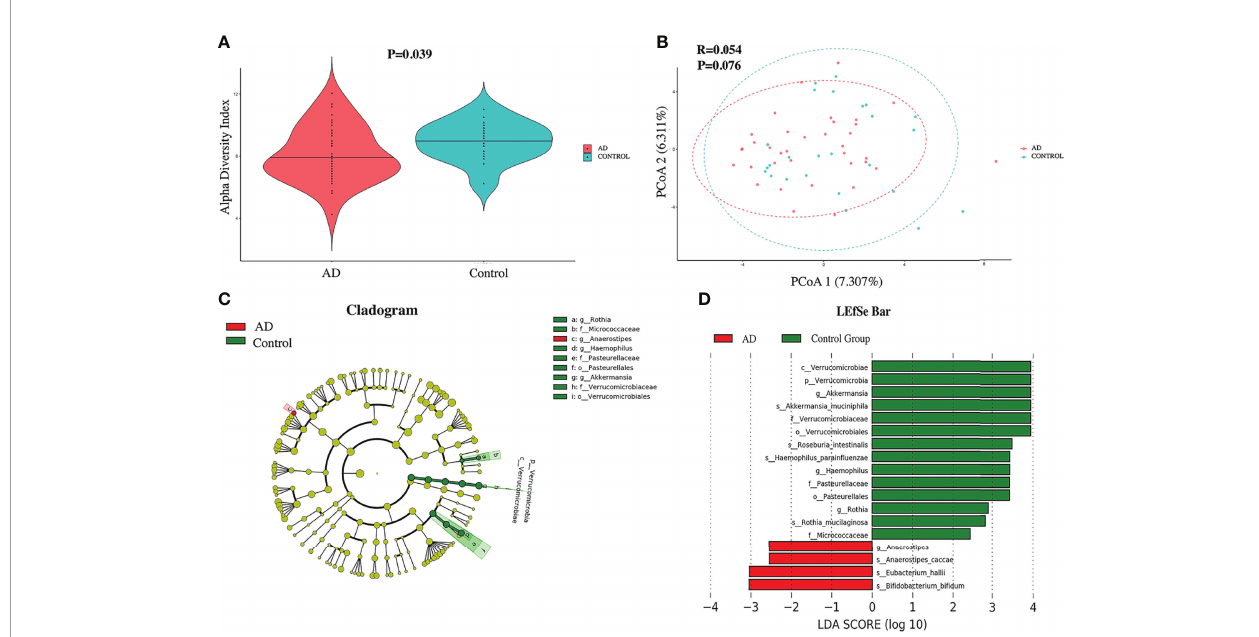
FIGURE 1 | The diversity and compositions of gut microbiota between autistic children with and without atopic dermatitis. (A) The violin plot of the alpha diversity index between two groups. (B) Principal coordinate analysis. (C) Red and green dots showed the relatively abundant bacterial taxa in AD individuals and the control group, respectively. Concentric rings from inside to outside were phylum, class, order, family, and genus. (D) Linear discriminant analysis (LDA) effect size (LEfSe) of gut microbiota. Those richer in AD individuals are represented in the red bar with a negative LDA score, and the control group in the green bar with a positive score. Only items with an absolute LDA value more than 2 are shown.